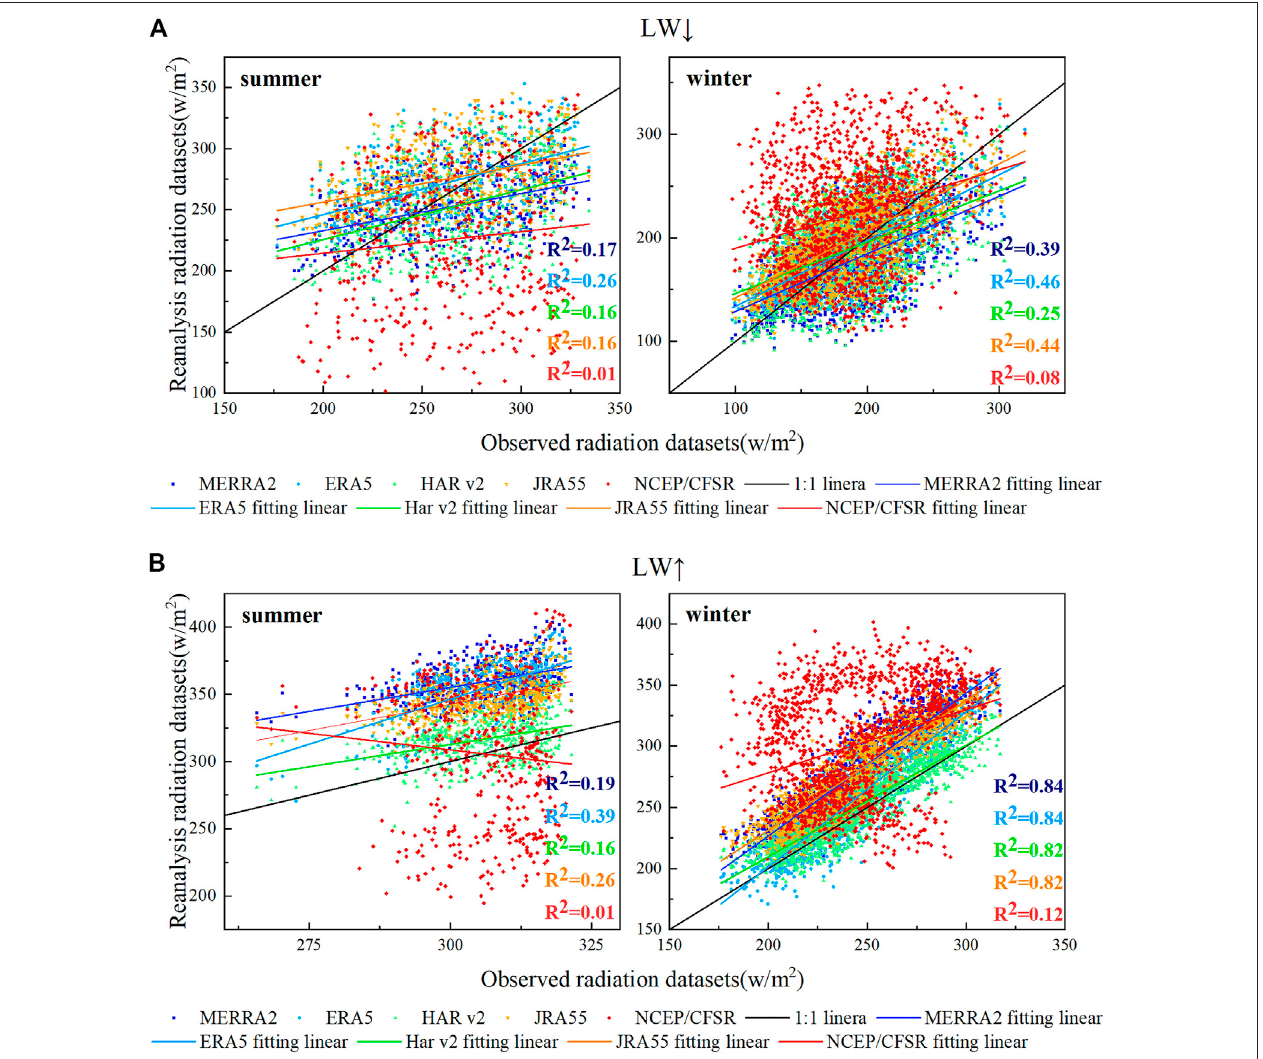
FIGURE 7 | Trends in observed and reanalysis longwave radiation datasets in different seasons; (A) and (B) represent downward longwave radiation and upward longwave radiation.